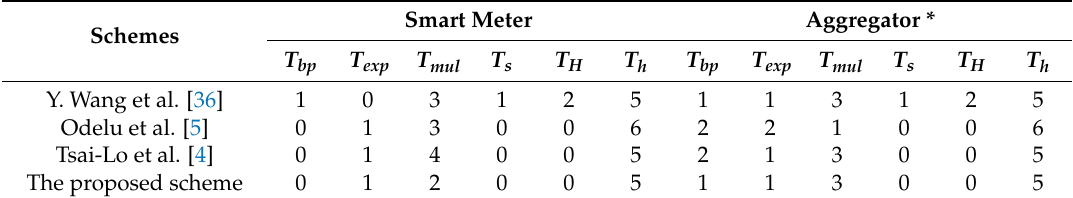
Table 15. Computation cost of different types of calculations at the authentication phase.